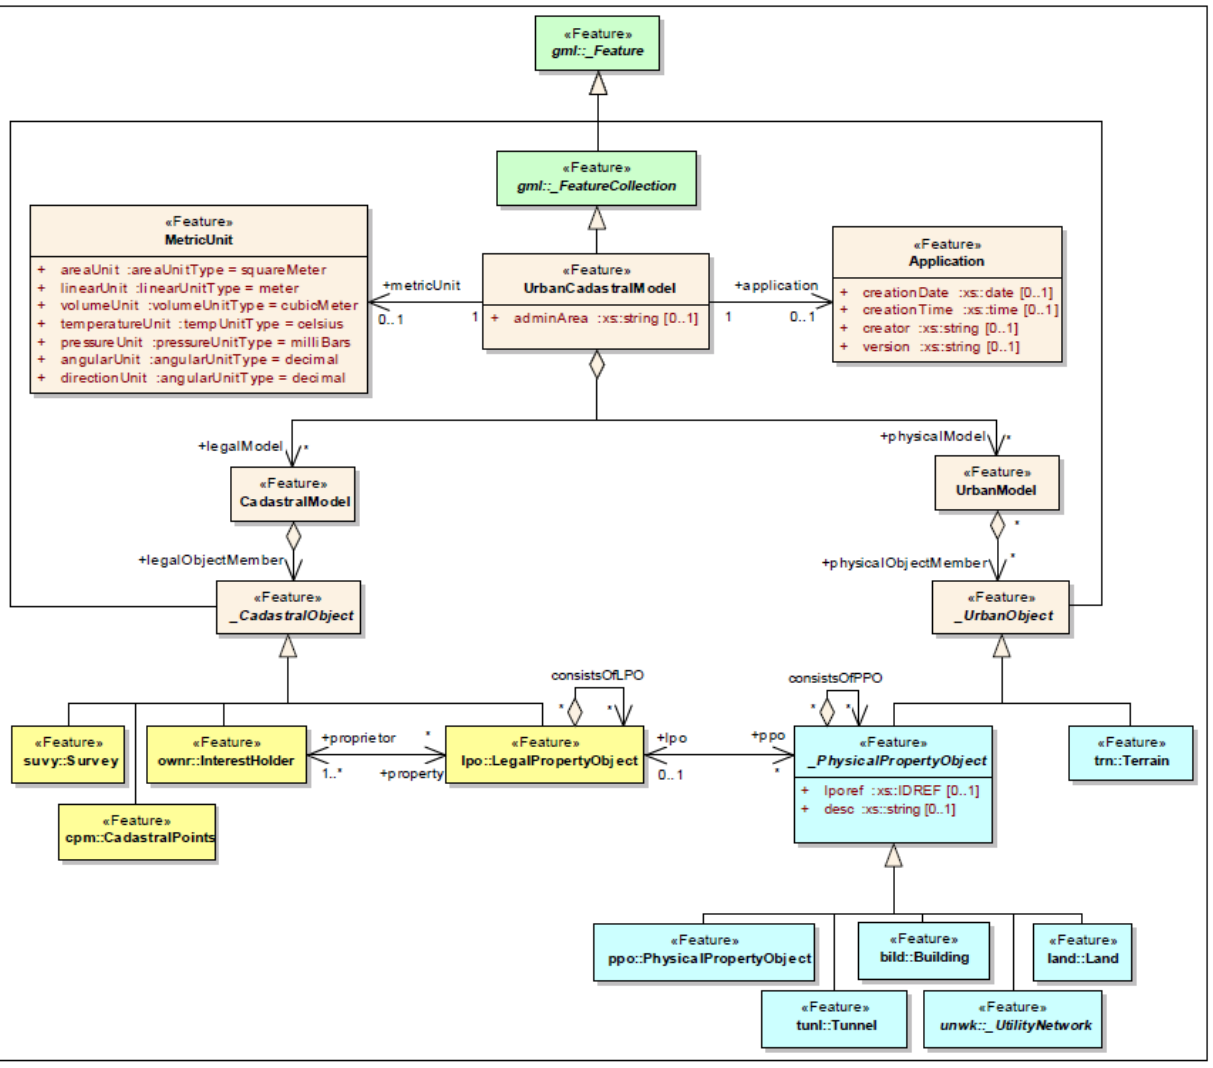
Figure 12. The UML diagram of 3DCDM Root model and subclasses of the legal and physical